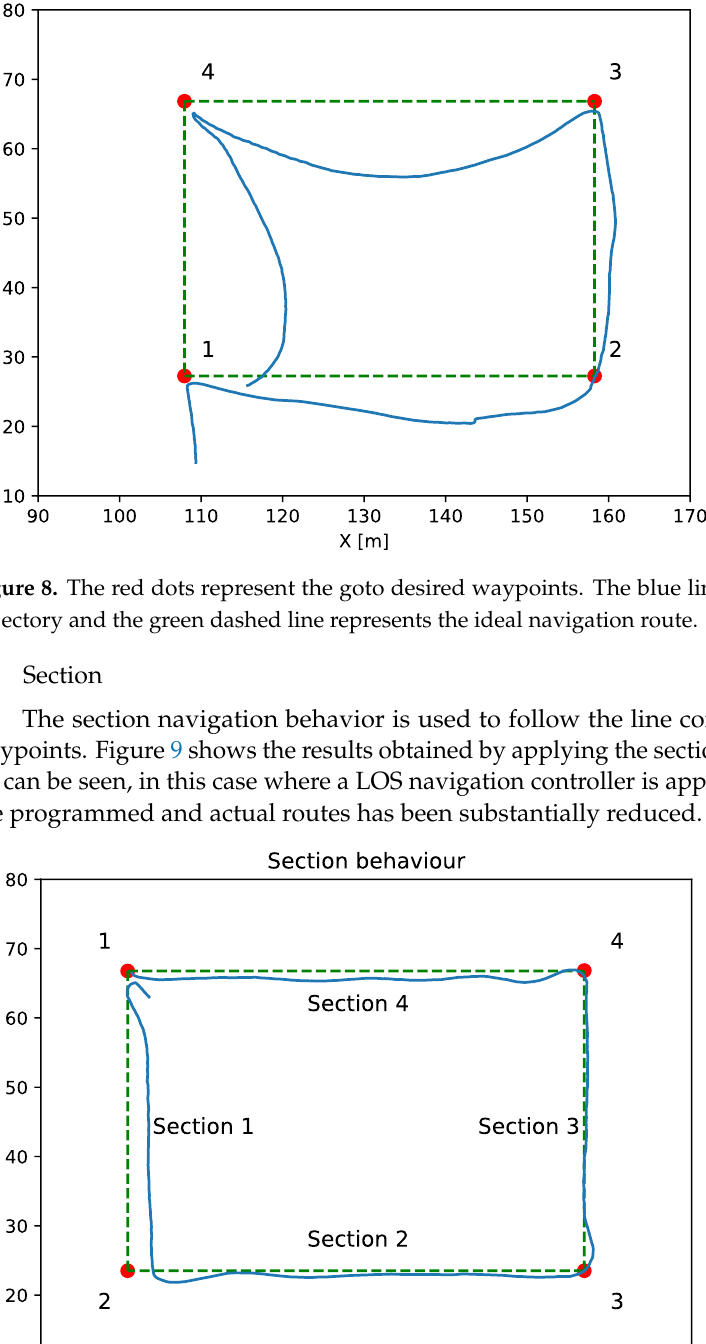
Figure 9. The green dashed line represents the programmed sections comprised between the waypoints represented as red dots. The blue line represents the vehicle route.